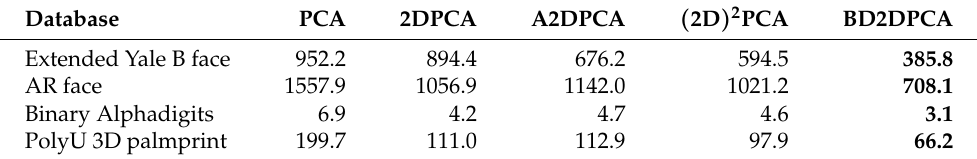
Figure 7. Average reconstruction errors of the five algorithms. ( a ) Extended Yale B face database. ( b ) AR face database. ( c ) Binary Alphadigits database. ( d ) PolyU 3D palmprint databse. Table 5. Average reconstruction errors of the five algorithms on four